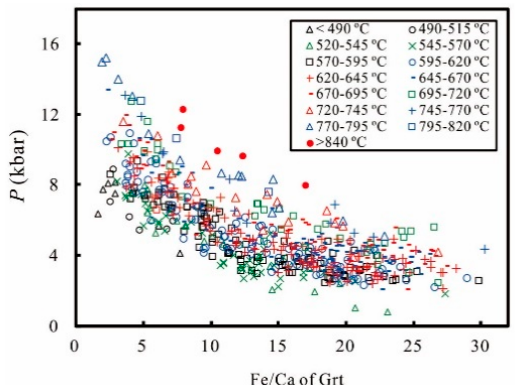
Figure 1. The metamorphic pressure is in negative relation to the Fe / Ca ratio of garnet at every 25 °C interval, as demonstrated by the natural metapelite samples collected from the literature (Table S1). The metamorphic pressure–temperature ( P–T ) conditions of these metapelite samples were determined simultaneously by the garnet-biotite geothermometer [55] in combination with the garnet–Al 2 SiO 5 –plagioclase–quartz (GASP) geobarometer